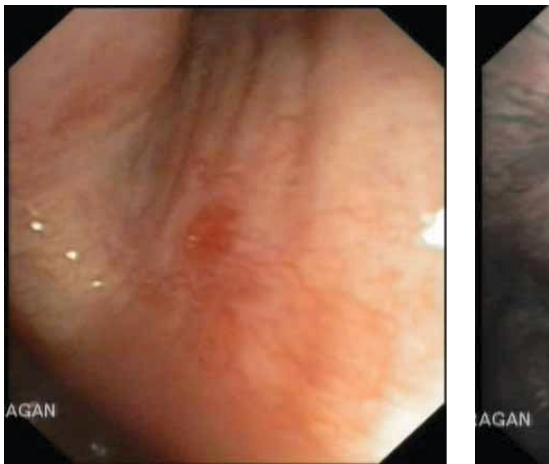
Figure 3. Preneoplastic lesion visualized using white light (left frame) and NBI technology (right frame).